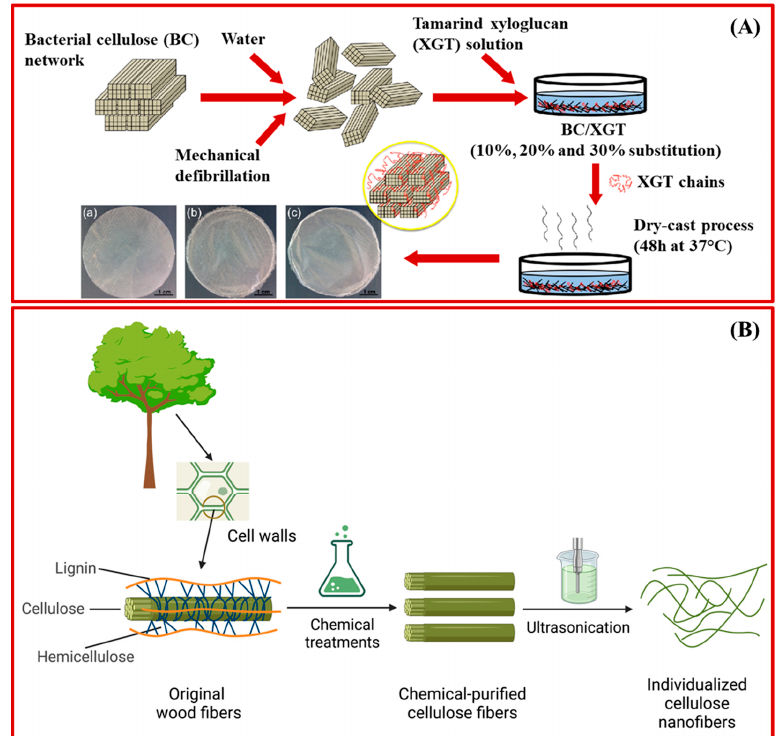
Figure 3. Schematic illustration of ( A ) bacterial nanocellulose (BNC) derived from biocomposite with xyloglucan. Optical images in panel A display the texture of biofilms of ( a ) bacterial cellulose, ( b ) reconstituted bacterial cellulose (RBC) and ( c ) RBC/tamarind xyloglucan biocomposite. ( B ) Schematic drawing of cellulose nanofibers (CNFs) extracted from wood using chemical and ultrasonication procedures. ( A ) is reprinted with permission from Ref. [58] Copyright 2017, Elsevier.